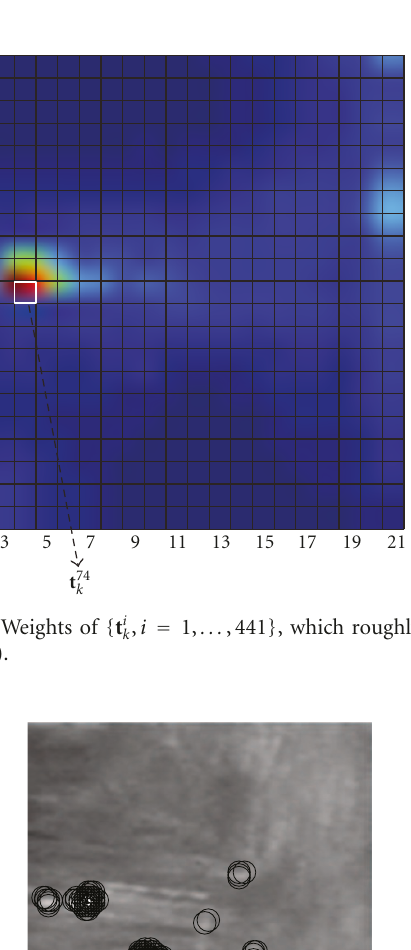
Figure 10: Tracked object accurately enclosed by a white